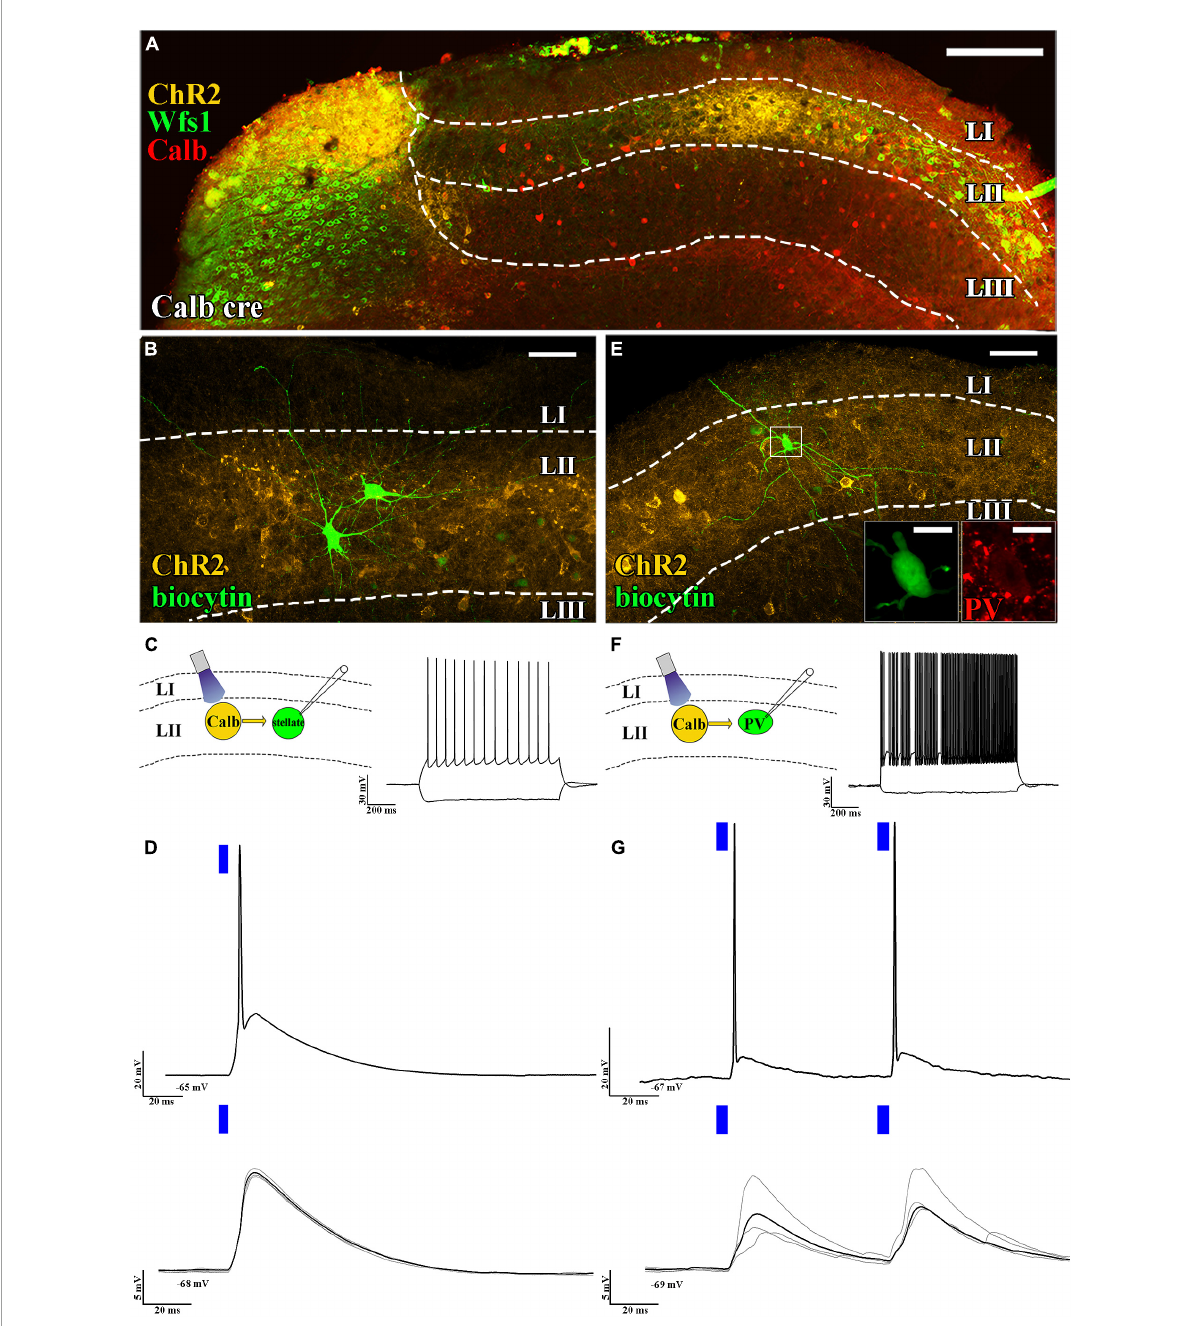
FIGURE1 Axons of layer II pyramidal cells mainly target layer II. (A) Low-magnification confocal images of the horizontally sectioned MEC of a Calb-Cre mouse showing Cre-dependent local ChR2 expression (yellow). This ChR2 expression is colocalized with the specific LII pyramidal cell markers WFS1 (green) and calbindin (red) (scale bars: 200 µ m). (B) High-magnification confocal images of a biocytin-filled layer II stellate cell and the surrounding ChR2-mCherry-positive axons (yellow) in the MEC of a Calb-Cre mouse (scale bars: 50 µ m). (C) Schematic representation of optogenetic recording setup (left) and response to hyperpolarizing and depolarizing current steps of the recorded stellate cells (RMP: –65 mV and –100 and +200 pA, above, scale bar: 30 mV and 200 ms). (D) Response of the stellate cell to a suprathreshold (5 mW, above) and a subthreshold (0.25 mW, below) single 5 ms (blue bar) light pulse (RMP: –65 mV and –68 mV, respectively, scale bar: 20 mV and 5 mV, respectively, 20 ms). The black trace represents the average, while the gray traces represent 4 consecutive sweeps. (E) High-magnification confocal image of a parvalbumin-positive (immunoreactivity shown in the inset, scale bar: 10 µ m) cell and the surrounding ChR2-mCherry-positive axons (yellow) in the MEC of a Calb-Cre mouse (scale bars: 50 µ m). (F) Optogenetic recording schematics (left) and response to hyperpolarizing and depolarizing current steps of the recorded parvalbumin-positive cell (RMP: –67 mV and –100 and +200 pA,